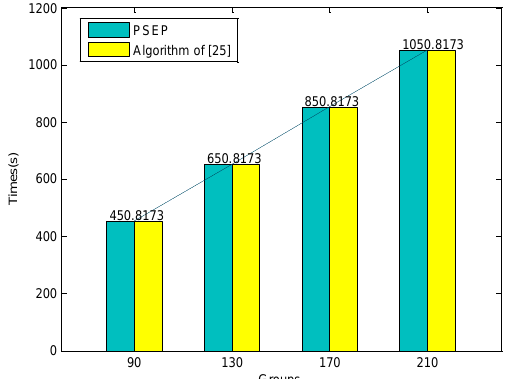
Figure 8. Comparison of their total evacuation time varying with the number of evacuation groups.